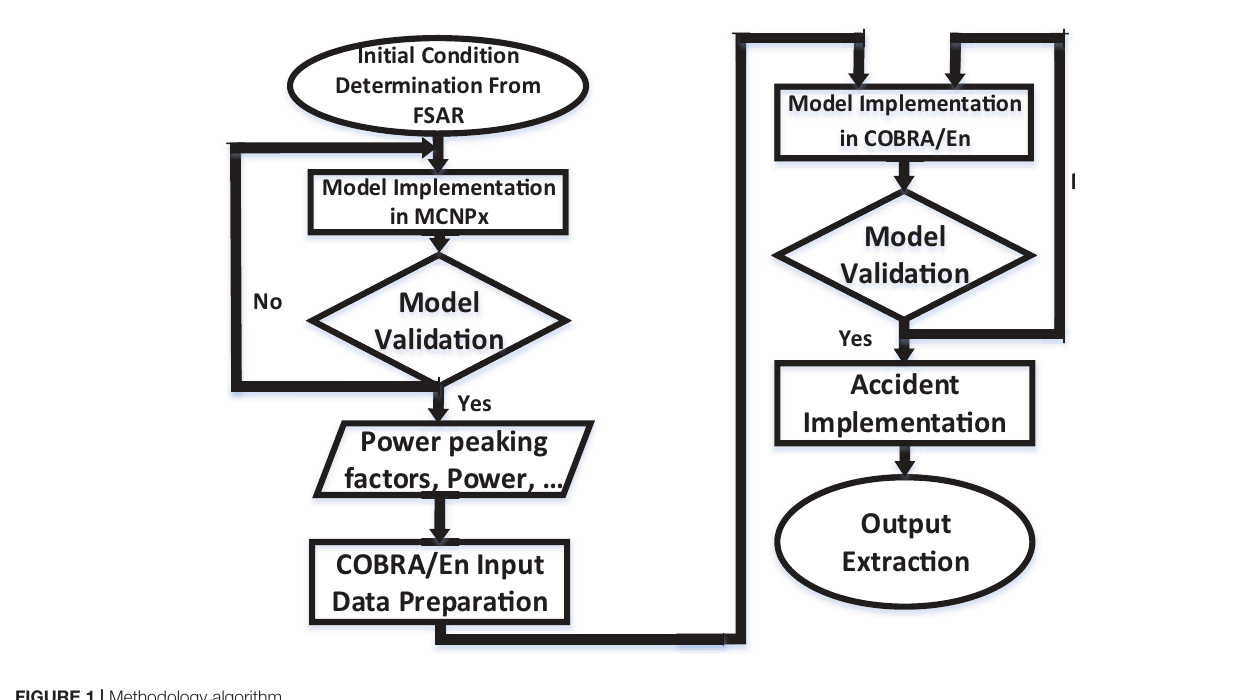
FIGURE 1 | Methodology algorithm.